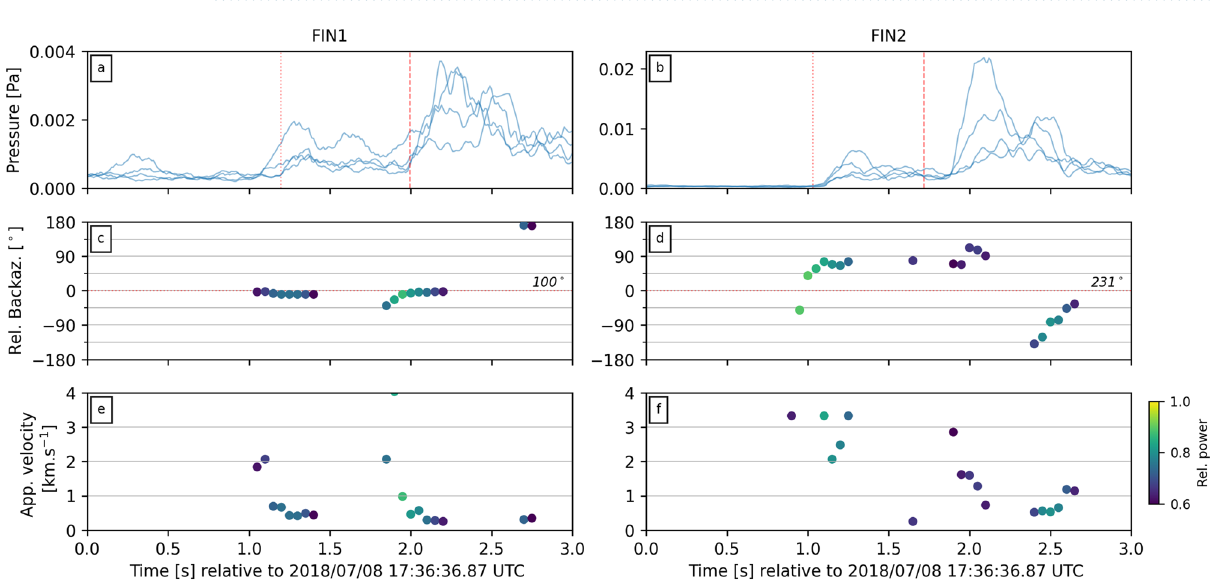
Figure 4. Beamforming results for arrays FIN1 (left column) and FIN2 (right column) for the first 3 seconds after the M w 1.87 event. ( a , b ) Smoothed waveform envelopes from each element in each array. Dotted and dashed lines plot the estimated arrival times of P- and S-waves, respectively (from epicentre to array). ( c , d ) Back azimuth calculations for 0.5 s moving windows with 90% overlap, relative to the theoretical back azimuth from array to the M w 1.87 event epicentre (horizontal dotted red line, absolute back azimuth value labeled on right hand side). ( e , f ) Calculated apparent velocity values across each array for each 0.5 s window. Points in panels ( c – f ) are colored by relative power, where lighter colors indicate higher relative